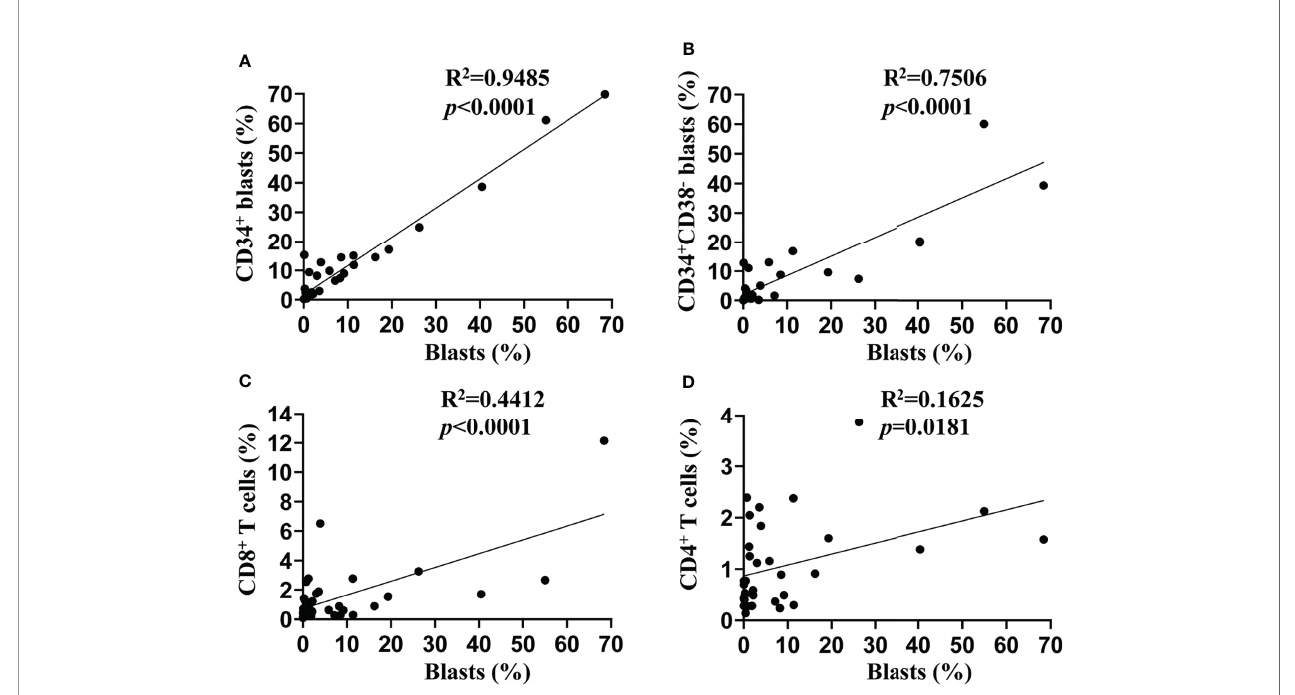
FIGURE 1 | Associations of TIM-3 expression between subtypes of leukemic blasts and T lymphocytes. TIM-3 expression levels on the surface of leukemic blasts and T lymphocytes from bone marrow samples of 34 de novo AML patients were assessed using fl ow cytometry. Linear regression was performed to show associations of TIM-3 expression level of the whole population of leukemic blasts with that of CD34 + leukemic blasts (A) , CD34 + CD38 - leukemic stem cells (B) , CD8 + T lymphocytes (C) and CD4 + T lymphocytes (D)